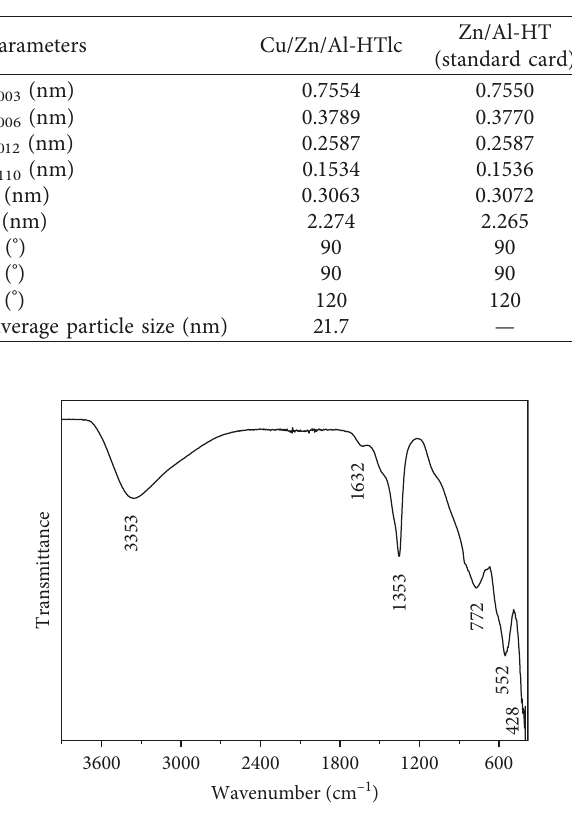
Figure 3: FTIR spectra of